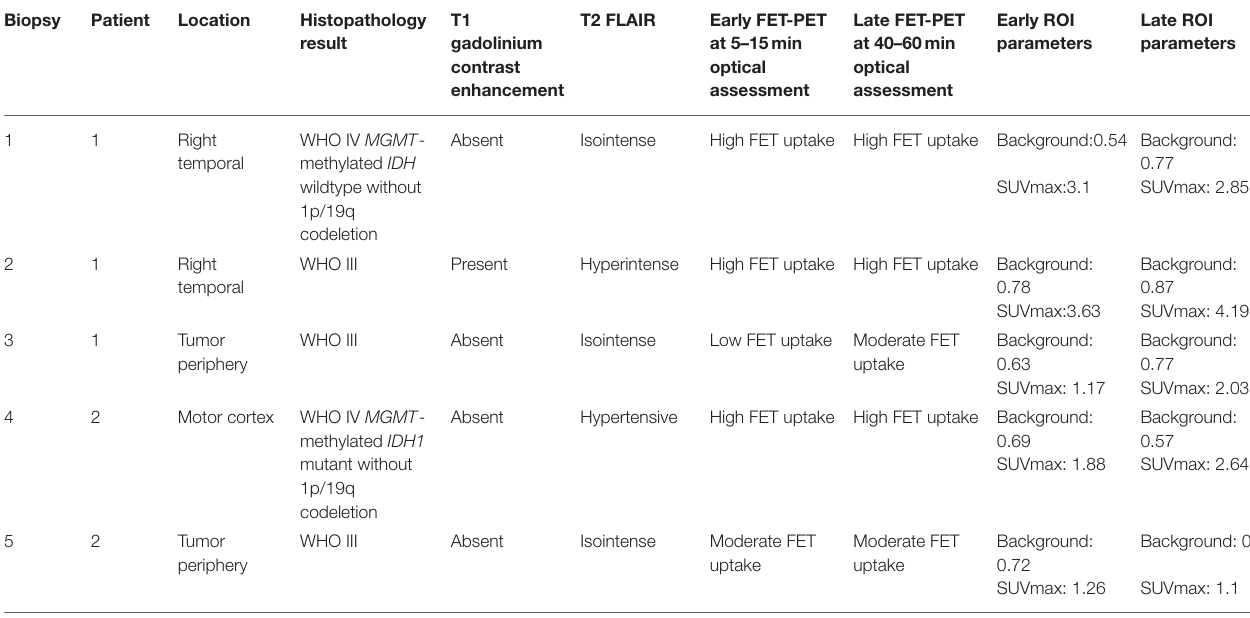
TABLE 1 | Summary of the biopsies, imaging findings, and histological diagnoses.